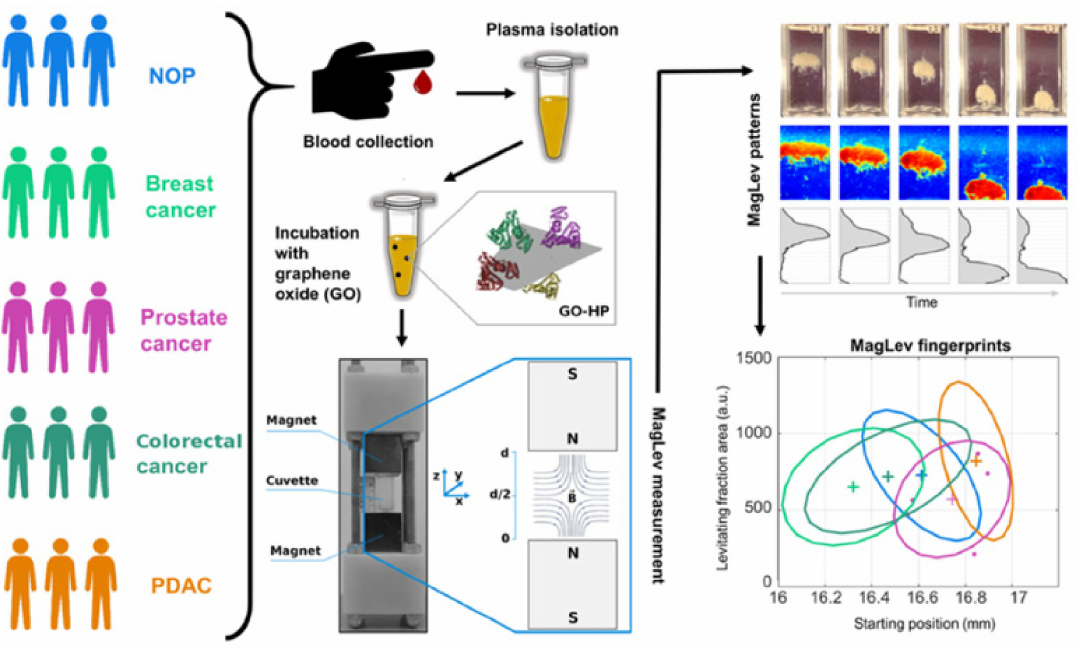
Figure 1. Scheme of the experimental workflow. Blood from donors belonging to 5 classes of physiological states was collected, then plasma was separated and incubated with graphene oxide (GO). GO–protein complexes were injected into a cuvette filled with a paramagnetic medium and inserted into a MagLev device. Levitation patterns were acquired, then processed to quantify MagLev profiles. Lastly, fingerprints for different cancer types were detected.